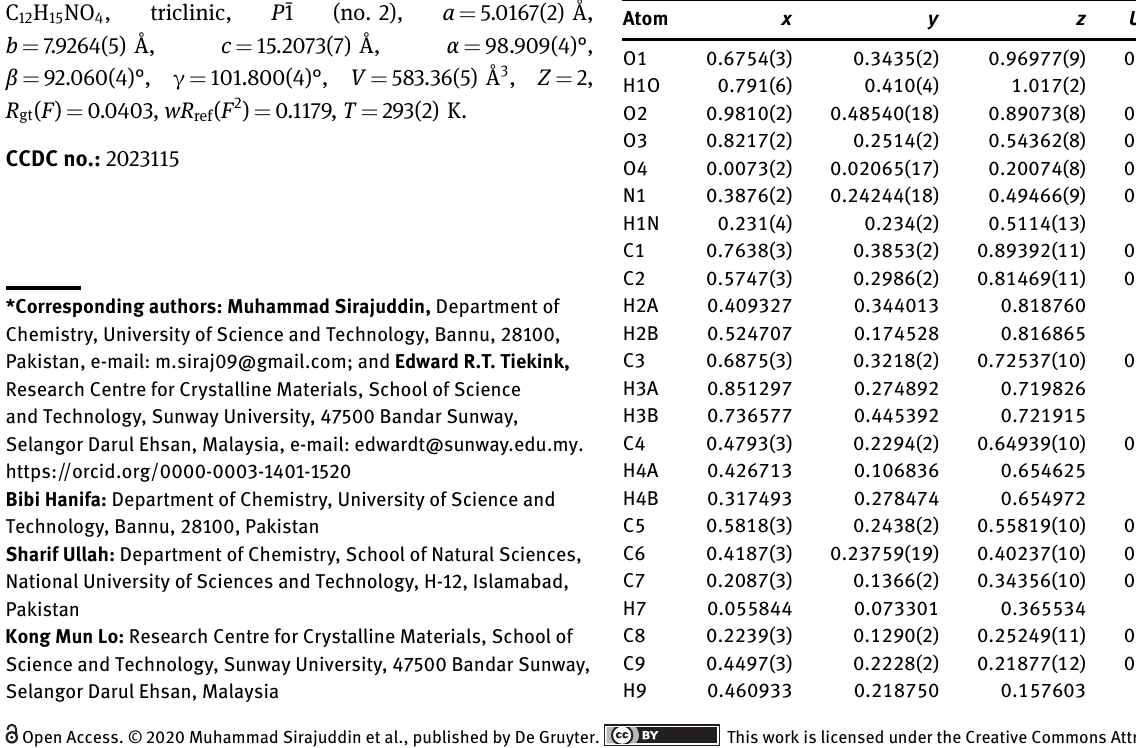
Table 2: Fractional atomic coordinates and isotropic or